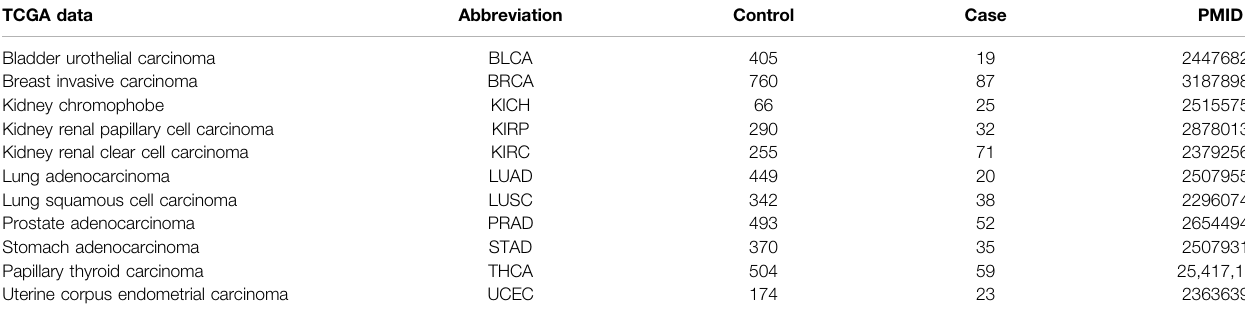
TABLE 1 | Details of the datasets utilized in